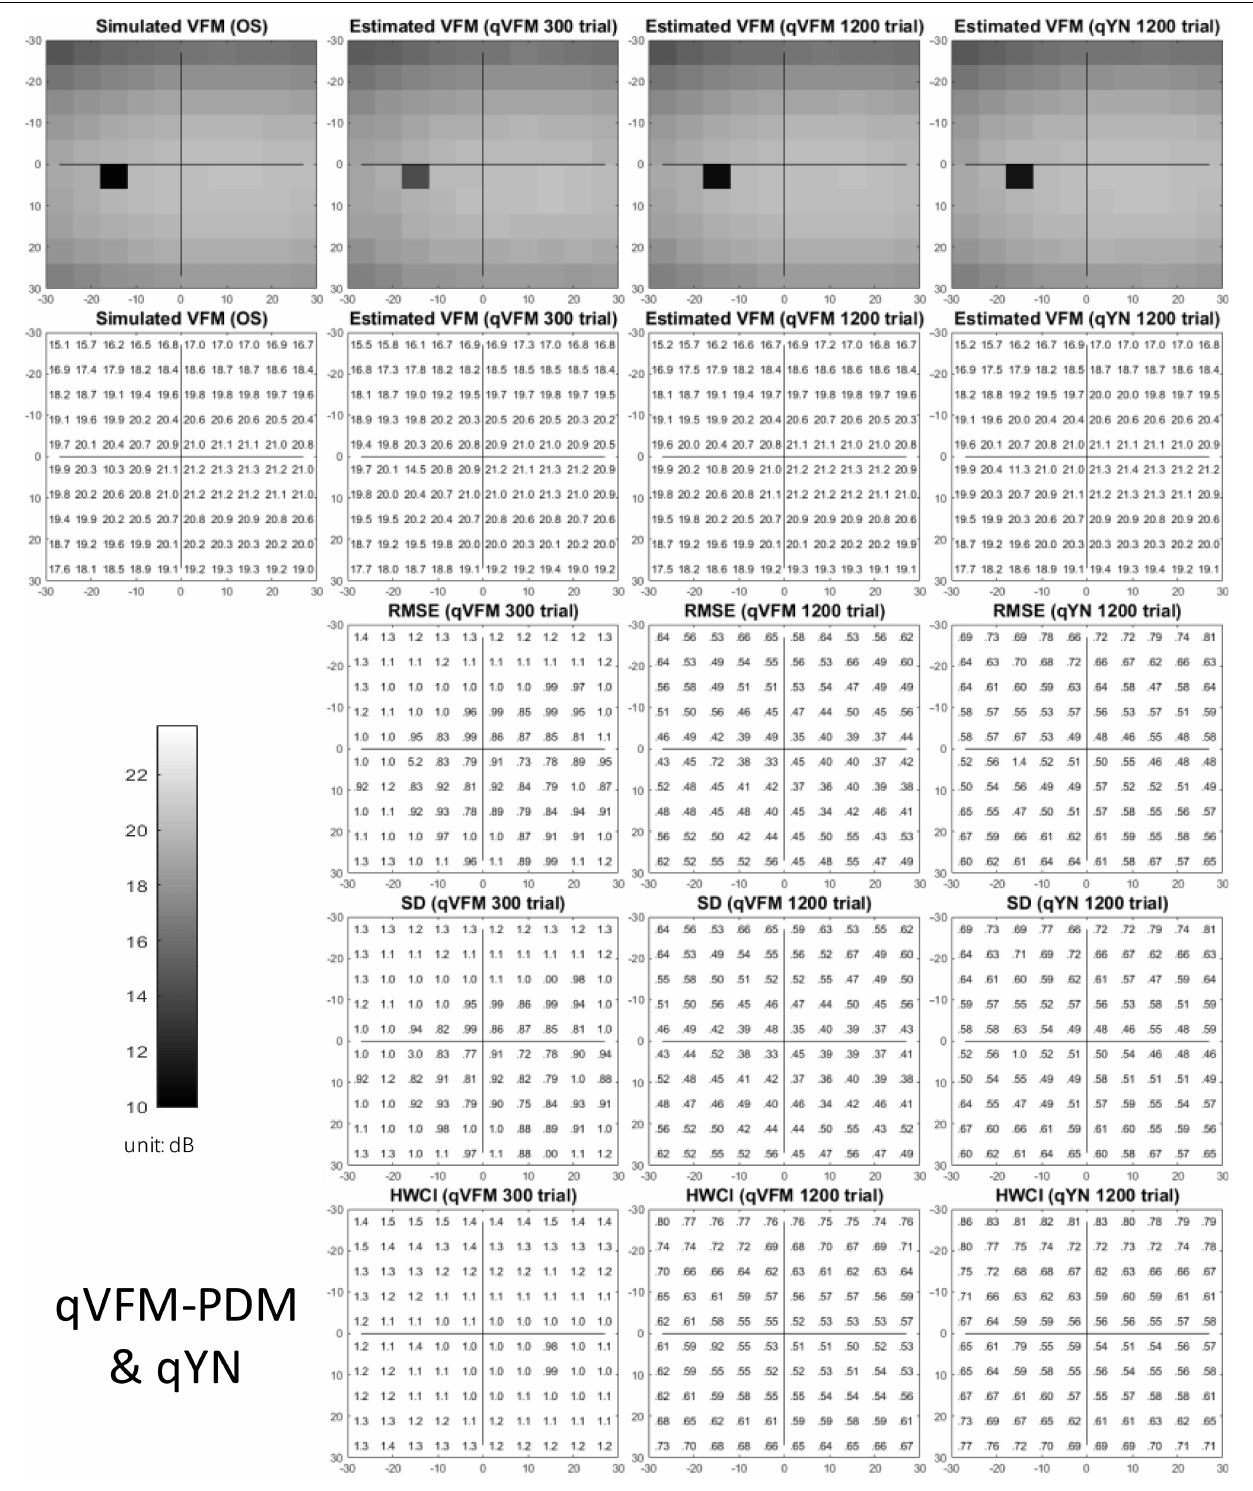
Frontiers in Neuroscience |